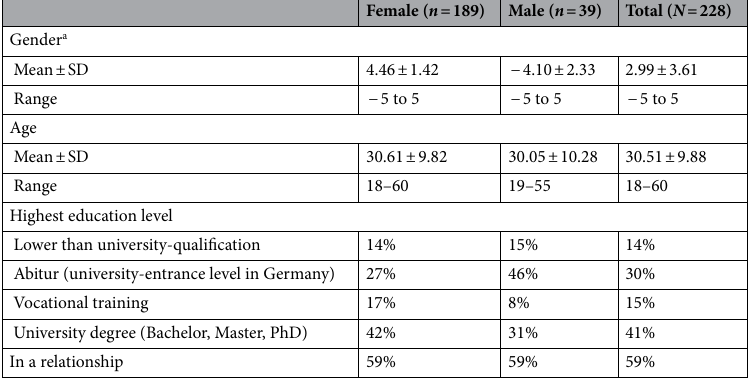
Table 4. Sample characteristics. Sample characteristics are presented separated by self-reported sex assigned at birth with four response options (female, male, divers, no answer). a Gender identification was assessed on a scale from − 5 = very masculine to + 5 = very